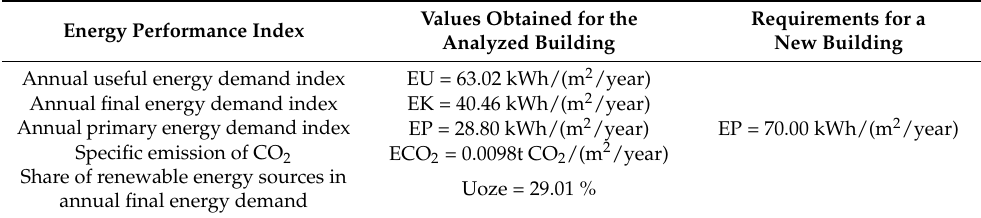
Table 5. Energy performance of a building using a heat pump and solar collectors in the heating system. Values Obtained for the Analyzed